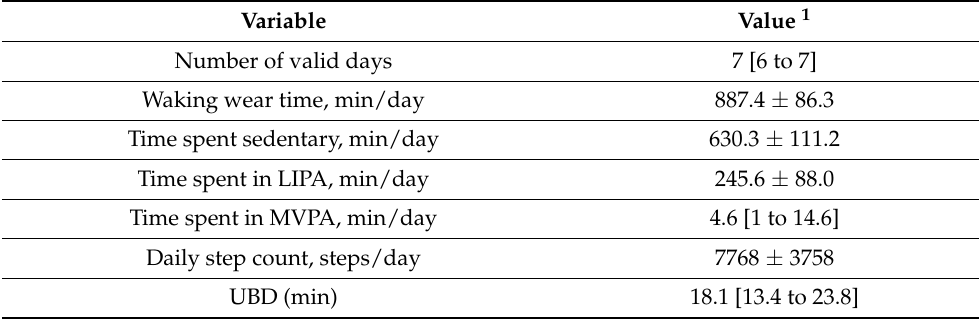
Table 2. Sedentary behaviour and physical activity among people with inoperable lung cancer